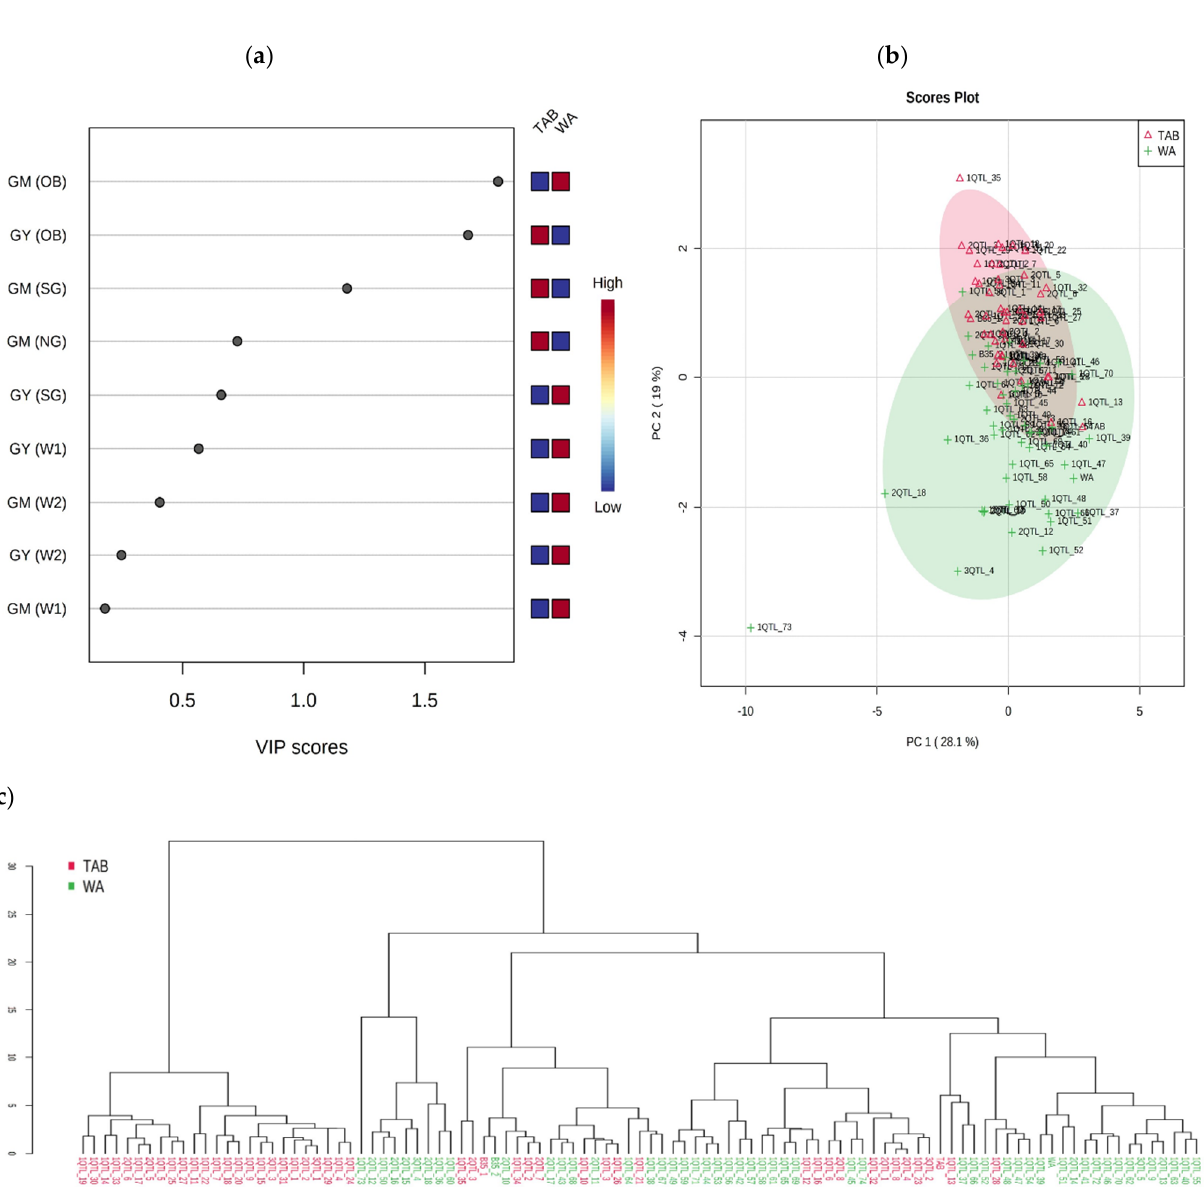
Figure 7. Pearson’s correlation of percentage greenness at maturity (GM), green leaf area at maturity (GLA.M), and grain yield (GY) of the ( a ) 46 and ( b ) 52 stay-green introgression lines and their parents‘Tabat’and ‘Wad Ahmed,’ respectively, under irrigated (W1) and drought (W2) at Khartoum North, and rainfed at South Gedaref (SG), North Gedaref (NG) and El Obaied (OB), . Absolute values > 0.30 were significant at ( p = 0.05) .